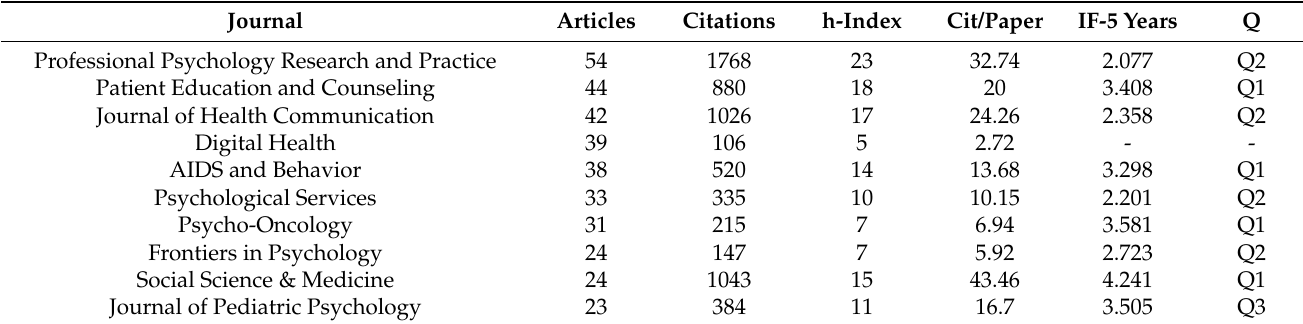
Table 4. Most relevant journals on the eHealth and Social Sciences.